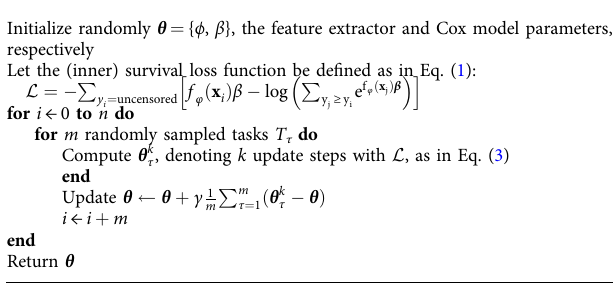
Algorithm 1 Meta-learning for few-shot survival prediction